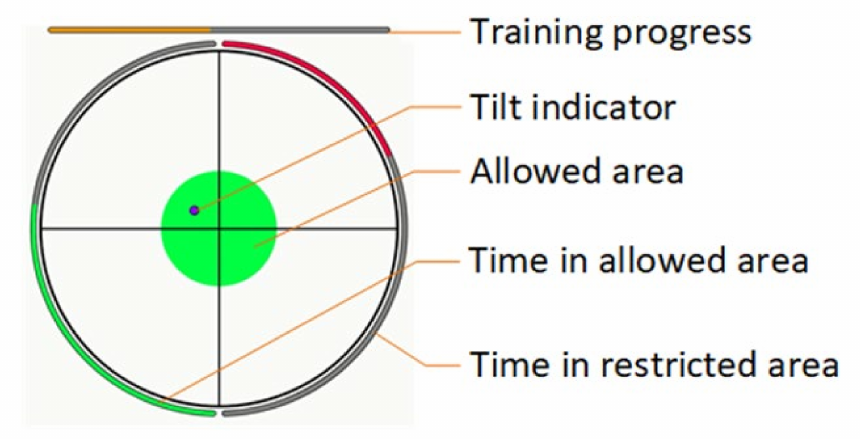
Figure 2. User interface for the experimental wobble